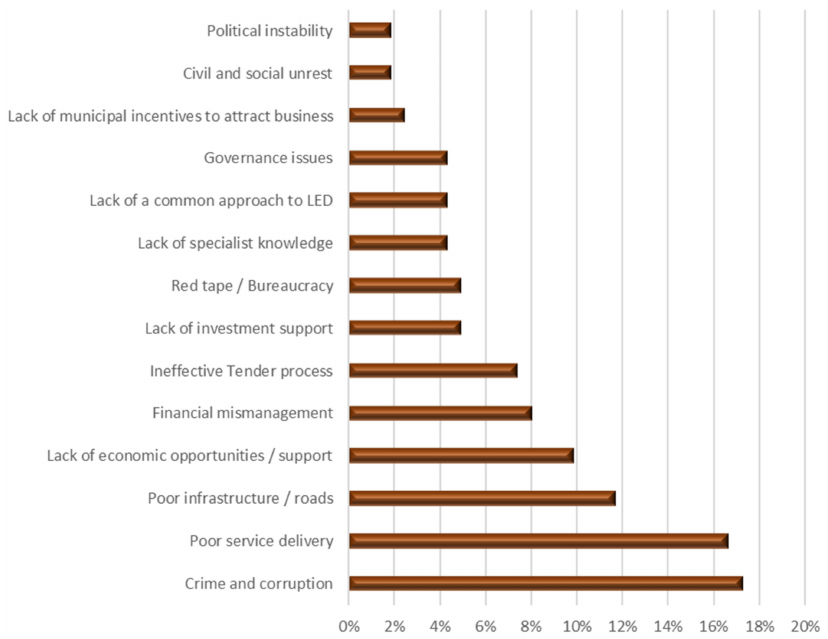
Figure 5. Business push